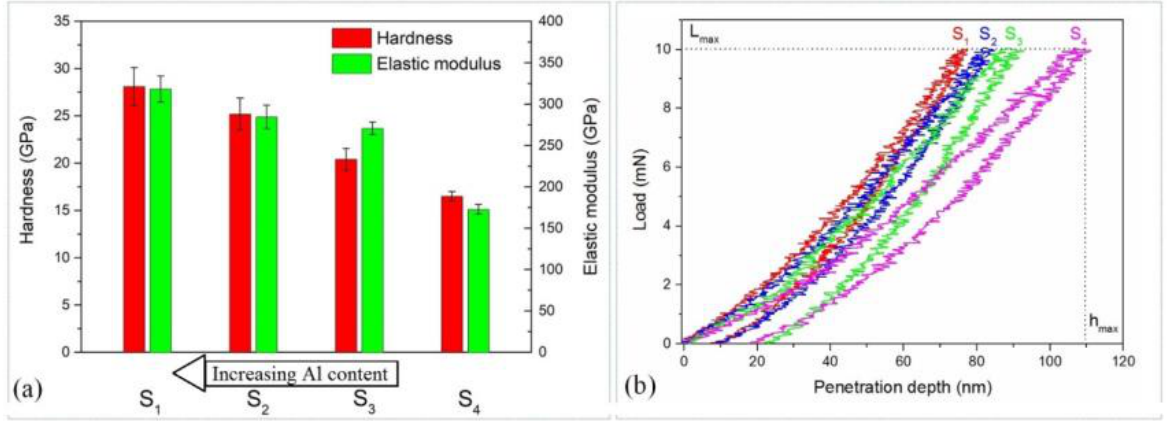
Figure 4. ( а ) Hardness, elastic modulus and ( b ) loading – unloading curves obtained for (Cr 1−x Al x )N Figure 4. ( a ) Hardness, elastic modulus and ( b ) loading–unloading curves obtained for (Cr 1 − x Al x )N coating after nanoindentation measurement. coating after nanoindentation